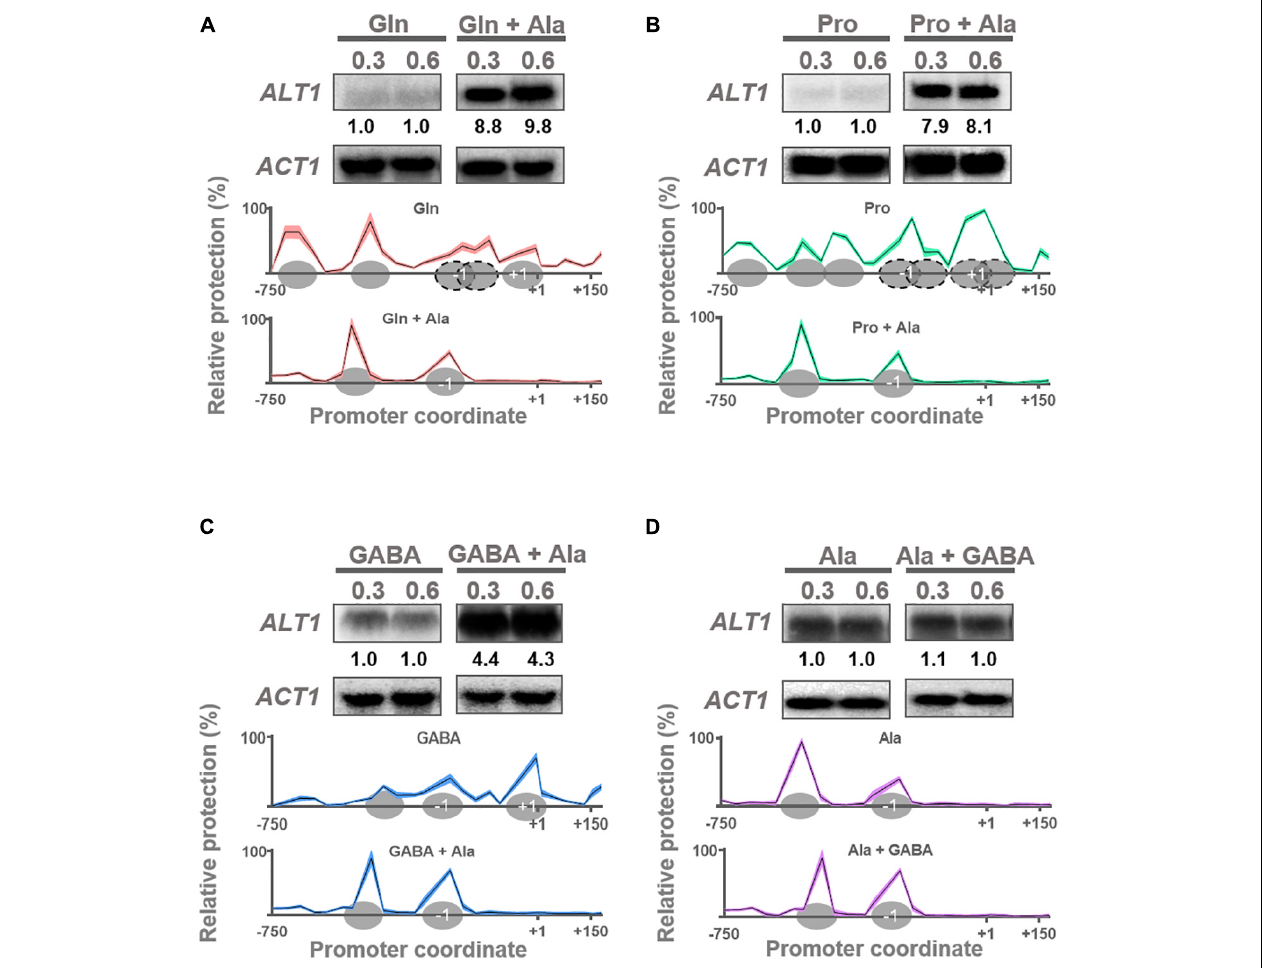
FIGURE 2 | ALT1 expression is induced in alanine, and nucleosome organization is modified accordingly. Northern blot and NuSA analyses. Expression of ALT1 and nucleosome promoter occupancy on ALT1 promoter was determined in (A) glutamine (Gln) and glutamine + alanine (Gln + Ala), (B) proline (Pro) and proline + alanine (Pro + Ala), (C) GABA and GABA + alanine (GABA + Ala), and (D) alanine (Ala) and alanine + GABA (Ala + GABA). For Northern blot analyses when each culture reached an OD 600 nm = 0.3, it was divided in two flasks. Alanine 7 mM was added to only one of the cultures. Both cultures (with and without alanine) were incubated at 30 ◦ C for additional 15 min. Then, samples of both cultures were taken for RNA extraction. Finally, a second sample of each culture was taken when cells reached an OD 600 nm = 0.6. All samples were prepared for RNA extraction followed by Northern blot assays as described in Materials and Methods . Numbers below the blots represent the fold change with respect to samples without alanine (A–C) or without GABA (D) after quantification and normalization relative to ACT1 . NuSA samples were obtained as mentioned previously for Northern blot analyses. Only NuSA results obtained at OD 600 nm = 0.6 are presented. Mean values of three independent experiments are shown as solid lines ± SE (shaded area). Ovals over x -axis indicate firmly positioned nucleosomes; dotted ovals depict fuzzy nucleosomes. Nucleosomes + 1 and –1 are indicated. ND, not